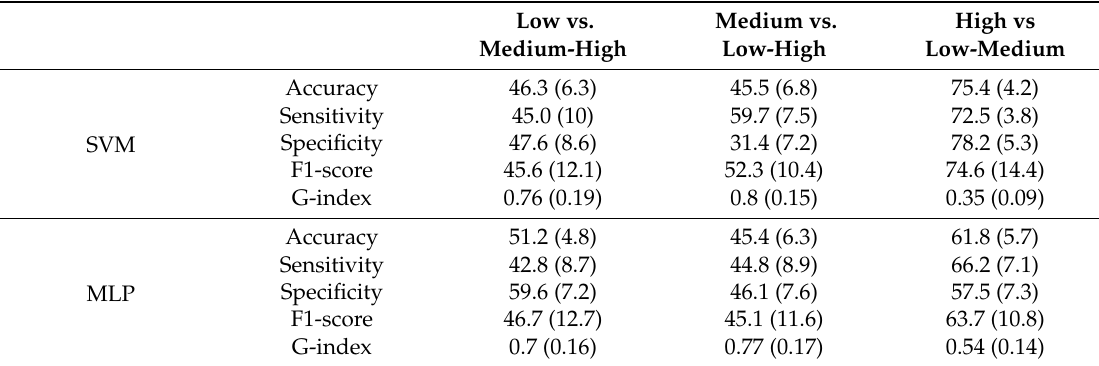
Table 3. The accuracy, sensitivity, specificity, F1-score, and G-index of the di ff erent combinations of the classes for SVM (support vector machine) and MLP (multi-layer perceptron)